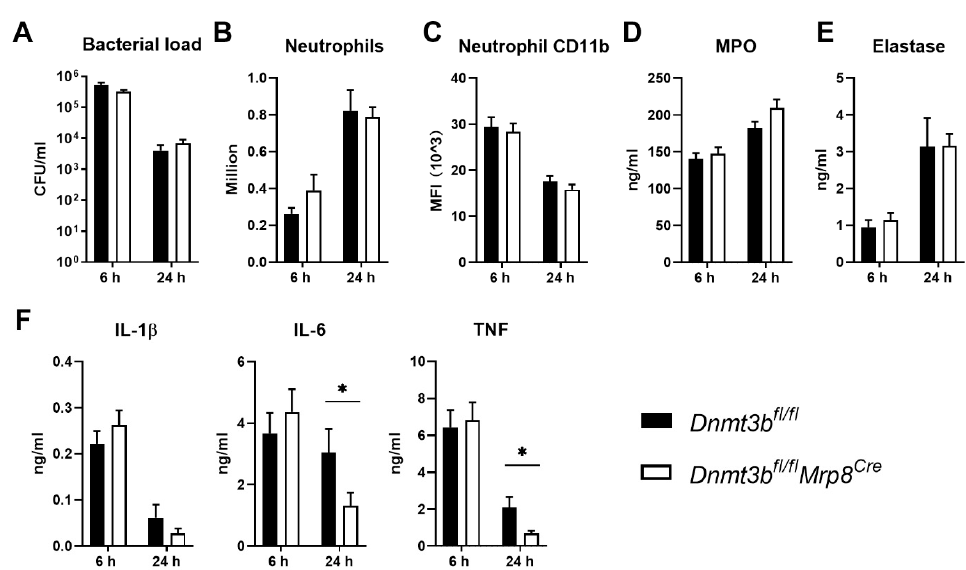
Figure 1. Neutrophil-specific Dnmt3b deficiency does not affect the acute host response during Pseu- domonas aeruginosa pneumonia. Neutrophil-specific Dnmt3b-deficient mice ( Dnmt3b fl/fl Mrp8 Cre ) and littermate control ( Dnmt3b fl/fl ) mice were infected with viable PAK (5 × 10 6 CFU) via the airways and euthanized 6 or 24 h after infection. ( A ) Bacterial counts (colony forming units, CFU), ( B ) neutrophil numbers, ( C ) neutrophil CD11b expression, ( D ) myeloperoxidase (MPO), ( E ) elastase, ( F ) IL- β , IL-6, TNF levels, all in bronchoalveolar lavage fluid (BALF). Data are shown as bar graphs with mean + SEM, n = 8. * p < 0.05.